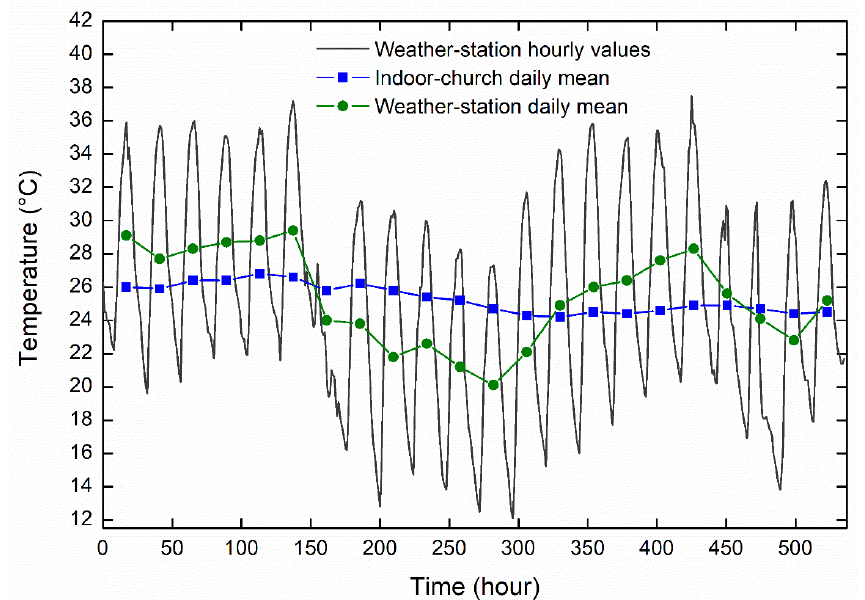
Figure 4. Time series of indoor temperatures of a church (XVIII century) for several days in summer compared to the outdoor hourly and daily average temperatures measured in the nearest weather station: indoor-church daily mean (blue); weather-station hourly values (dark gray); weather-station daily mean (green).